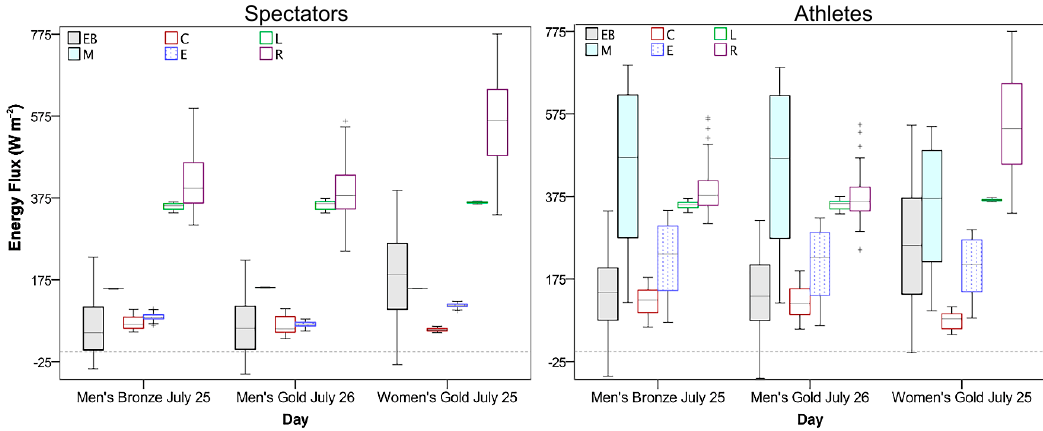
Figure 4. Stem and leaf box plot depicting the estimate range of the energy budget values (EB) on each day (spectators left plot; athletes right plot). Energy flux gains and losses also shown: metabolic heat gain (M); absorbed radiation heat gain ( R abs ); convective heat loss (C); evaporative heat loss (E); and longwave emission heat loss ( L emit ) in Wm − 2 . The interquartile range (IQR) is indicated by the length of each box plot (25th to 75th percentiles), with outliers (values 1.5 – 3 IQRs from box end) marked by °.